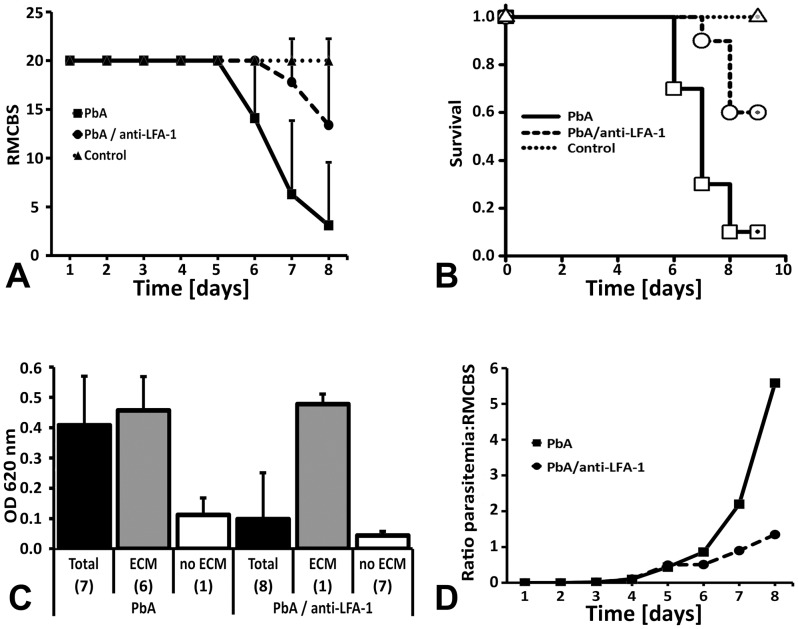
LFA-1 mediated cellular interactions contribute to BBB opening.Five days after infection with PbA, CBA/CaJ mice were inoculated with 200 µg anti-LFA-1 mAb (N = 10) or no antibody (N = 10). A) Neurological signs based on RMCBS grading were significantly reduced in anti-LFA-1 treated PbA-infected mice compared to the untreated PbA-infected control mice. The data are represented as average ± SD. B) While 90% of the PbA-infected mice (N = 10) developed severe ECM between day 6 and 8, only 40% of the anti-LFA-1 treated mice (N = 10) showed neurological signs. C) Compared to PbA-infected untreated mice (N = 7), anti-LFA-1 treated PbA-infected mice (N = 8) exhibited a significant reduction in vascular leakage in the brain. Separate graphic representation of the 1 ECM-negative and 6 ECM-positive mouse brains from the PbA group and the 1 ECM-positive and 7 ECM-negative mouse brains from the PbA/anti-LFA-1 group revealed that neurological signs and vascular leakage are directly correlated. The data represent the average OD620 measurements from the two brain hemispheres from each mouse ± SD. Three of the 10 PbA-infected mice and 2 of the 10 PbA-infected/anti-LFA-1 treated mice died overnight and were excluded from analysis. D) Depiction of the parasitemia-to-RMCBS ratio accentuates the effect of LFA-1 blockage on the development of neurological signs.